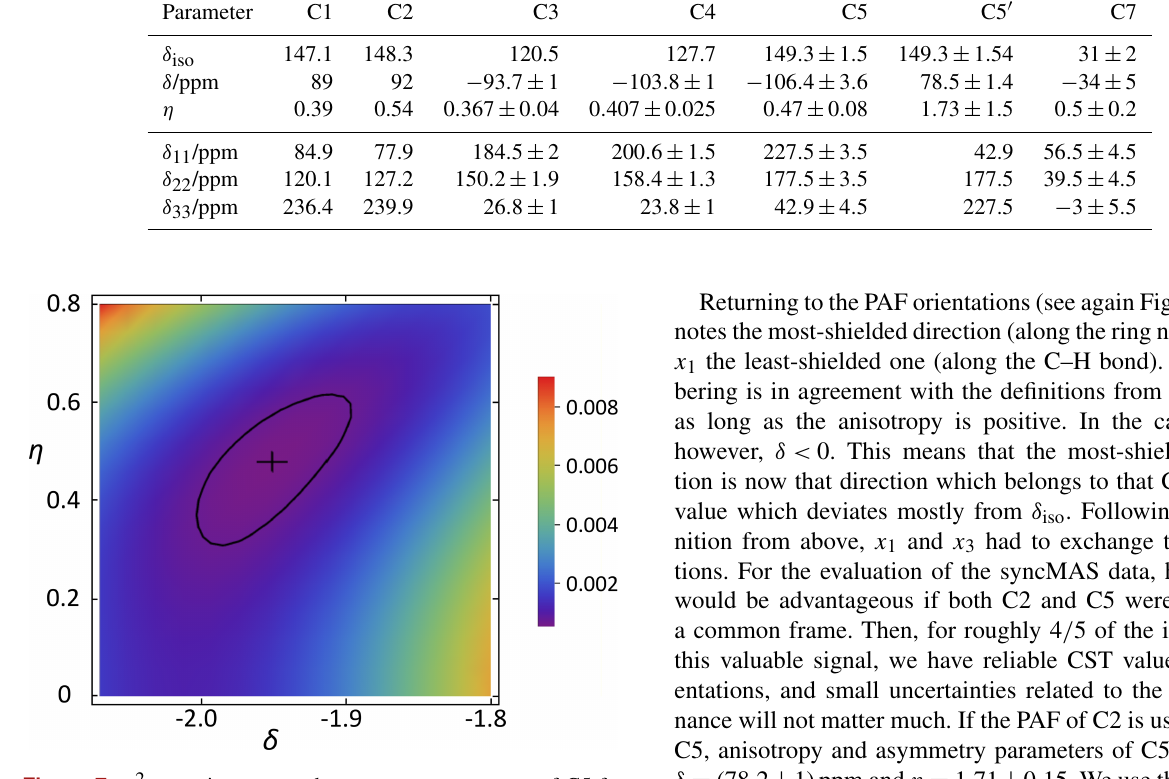
Figure 7. χ 2 vs. anisotropy and asymmetry parameters of C5 for p = 0 . 5. The cross marks the minimum position; the solid line shows the confidence